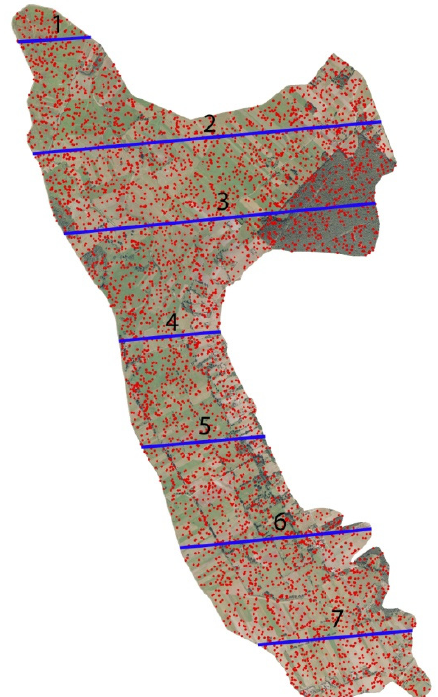
Figure 4. Cross-section of the polder and location of the points that were used to estimate the mean square error (RMSE).